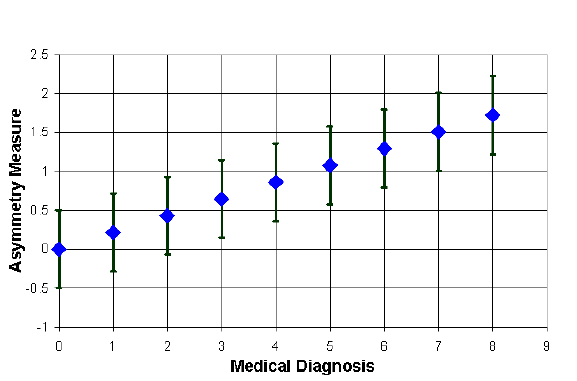
Figure 11. Asymmetry measure vs medical